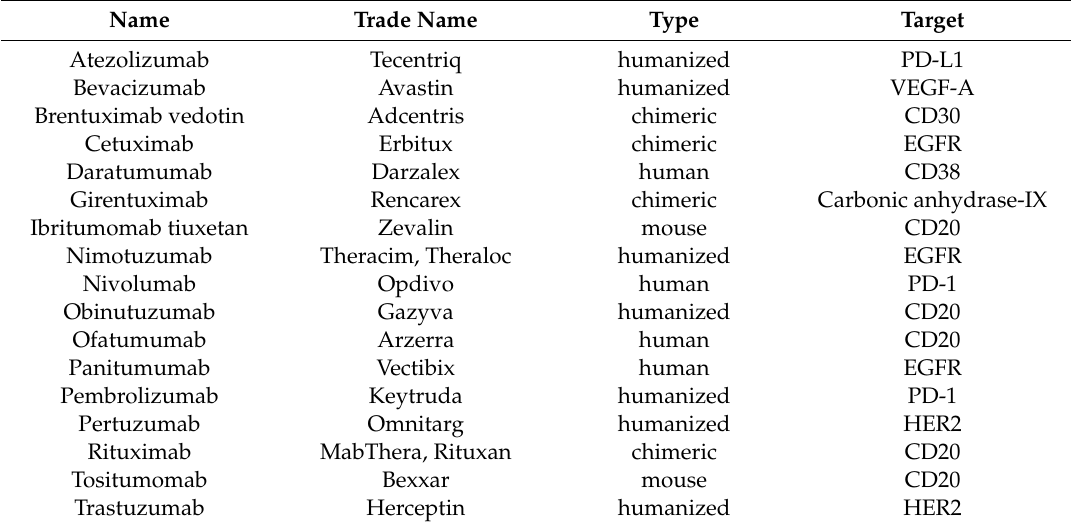
Table 1. FDA-approved mAbs used for